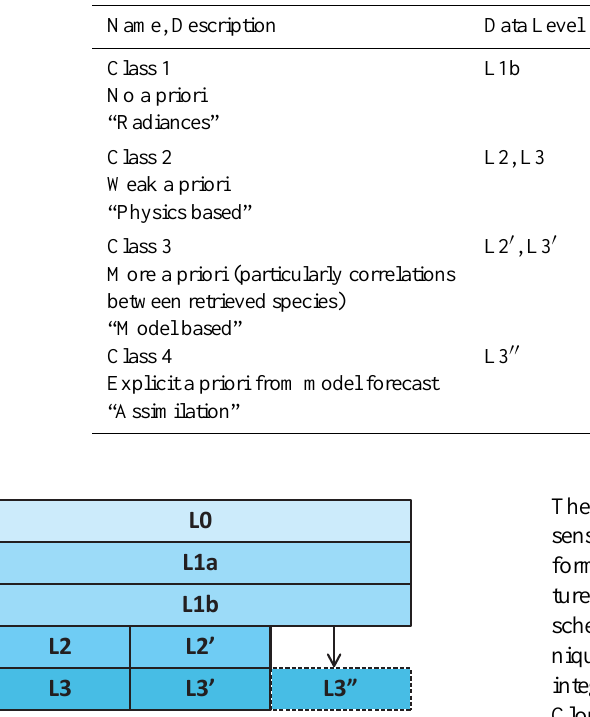
Fig. 5. Data levels. L0 are raw data. L1a are raw data with cali- bration coefficients, L1b are calibrated radiances in units of Planck brightness temperatures. L2 and L2 0 are retrieved parameters for each instrument field of view. L3, L3 0 , and L3 00 are retrieved pa- rameters on standard grids. The processing chain progresses from the top down, so L3 0 depends on L2 0 , and so on. L3 00 is special, because it depends directly on